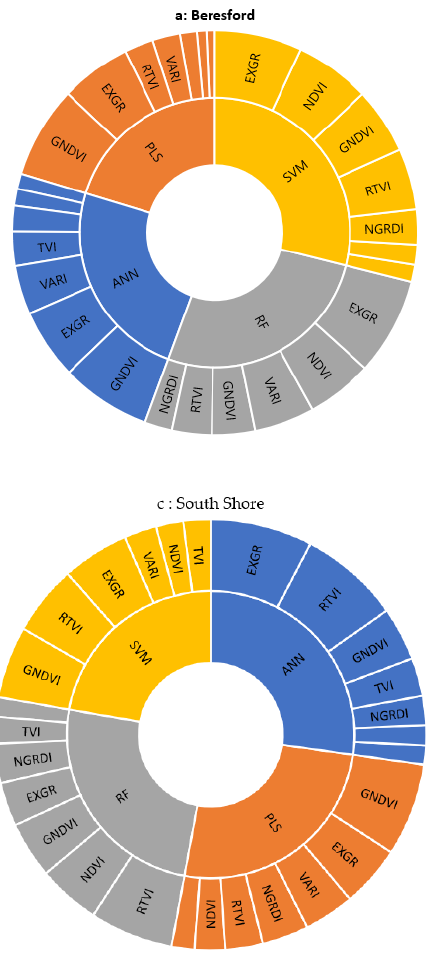
Figure 10. Importance scores for predictor variables at Beresford ( a ), Volga ( b ), and South Shore ( c ) aggregating data from pre- and post-heading flights.